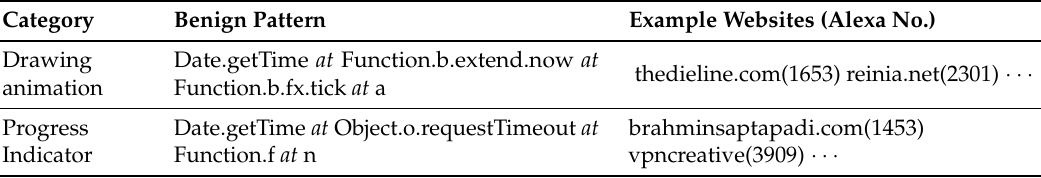
Table 2. white-listed behavior patterns of pixel- and repainting-based timing probing